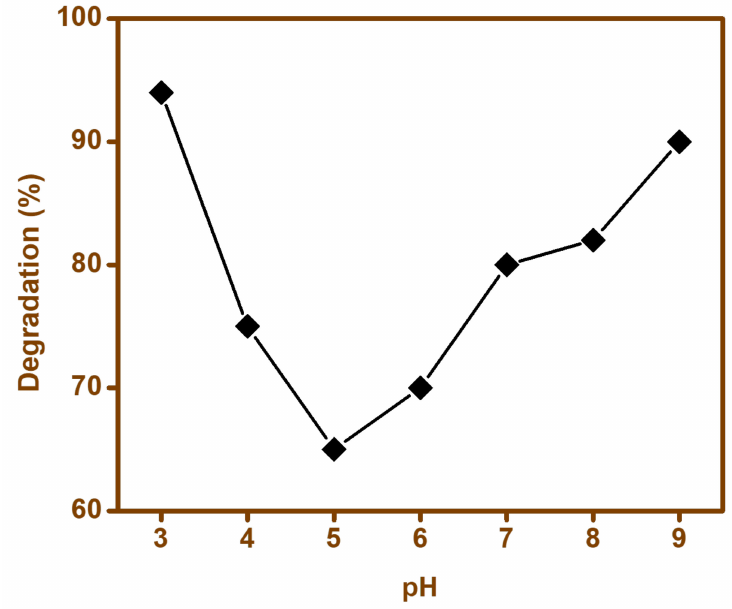
Figure 13. Effect of pH on the degradation of cefixime trihydrate. The reusability of the BFO-M was evaluated by cefixime trihydrate degradation under visible light for up to three cycles. After each reaction, BFO-M was removed from the liquid mixture, washed twice with deionized water, and finally dried at 80 ◦ C. The degradation rates of recovered BFO-M were slightly less (91%, 90%, and 90.5%) than first-time use under optimized conditions (94%) (Figure 14). These close values indicated a good measure of stability, and suggested the reusability of the photocatalyst without significant losses in catalytic